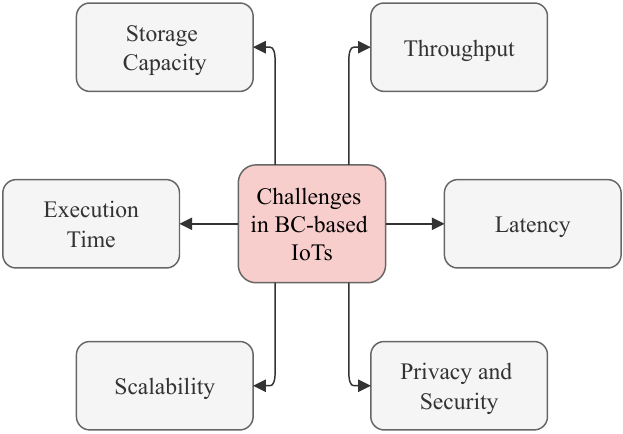
Figure 6. Challenges in BC-based IoT applications.